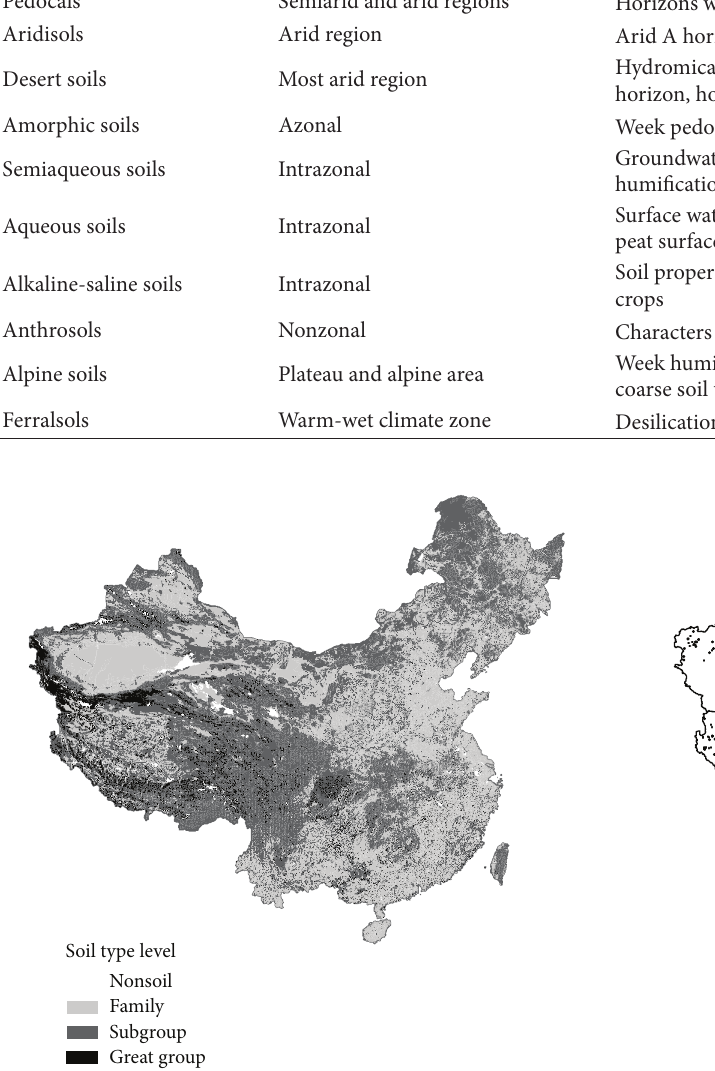
Figure 1: Soil taxonomic level of the 1: 1,000,000 soil map of China [13].